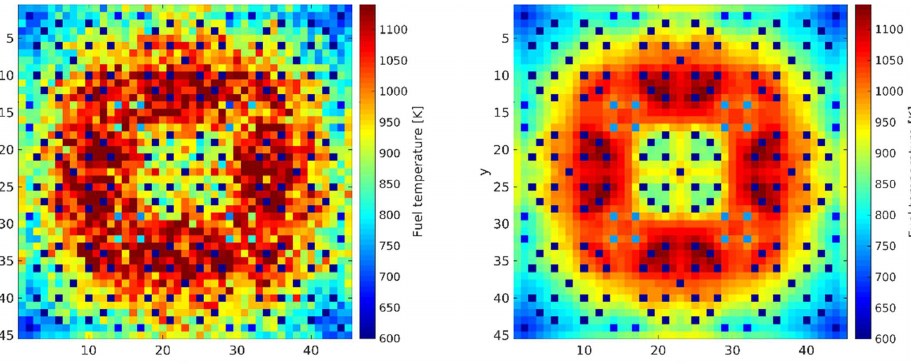
Fig. 7. Pin-wise fuel temperature distribution at the converged state, for Run #2 (left) and Run #1 (right) accumulated during the corresponding time